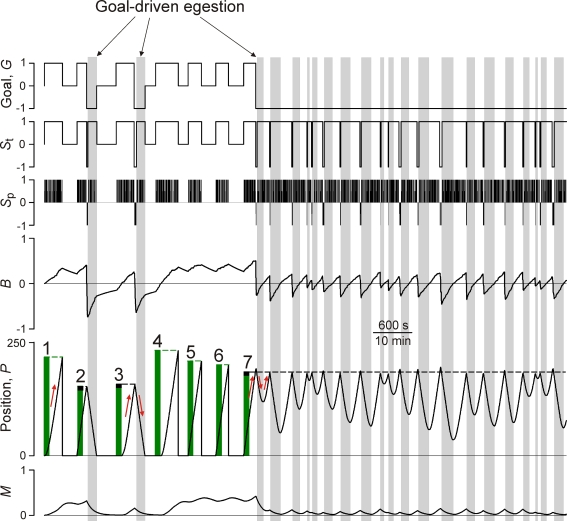
Characteristic modes of behavior of the 2D model in Task 2.Representative simulation at τ = 200, f = 0.1, showing (top to bottom) the goal G, the true stimulus S
t, the perceived stimulus S
p, the behavior B, the position P on the seaweed strip (the red arrows show the direction of movement), and the memory M. The vertical green bars show the lengths of seven seaweed strips presented at those times, some of the strips (1, 4, 5, and 6) being free and others (2, 3, and 7) attached, the latter indicated by the black color of their ends. The model proceeds through the simulation, completely ingesting all of the strips and, on finding strips 2 and 3 to be attached, egesting them again completely, but then fails to completely egest strip 7 and continues to oscillate back and forth on it, egesting part of it and then ingesting it again, essentially indefinitely. The vertical grey bars indicate periods of goal-driven egestion, that is, when, with G = −1, B<0 even though S
t = 1.